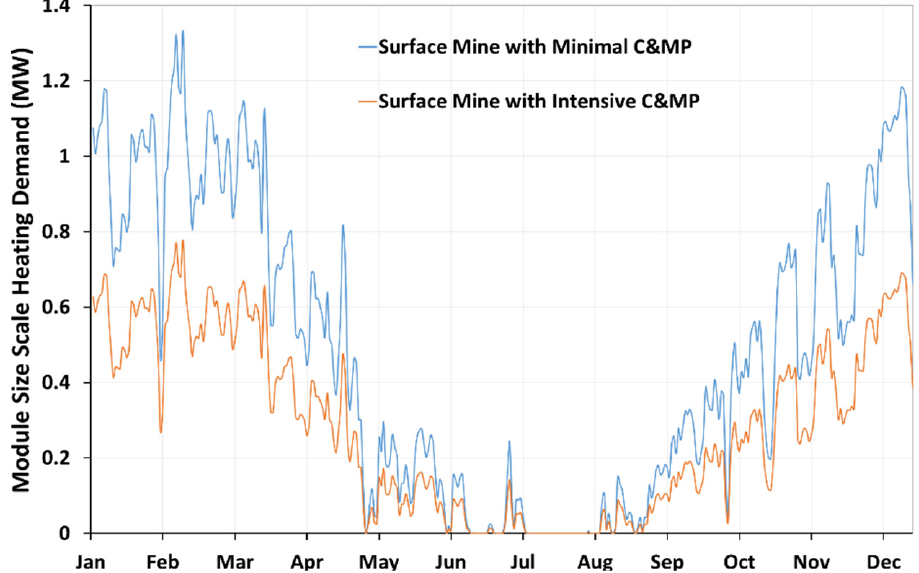
Figure 10. The site’s modular size scale heating demands for minimal and intensive C&MP scenarios.